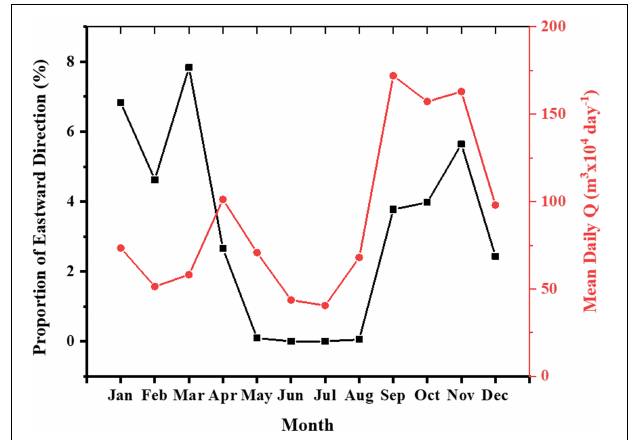
FIGURE 2 | Comparison of longshore currents direction on the north coast as measured by the San Juan buoy vs. mean RGM streamflow for 2012–2019. Red dots and black squares represent the mean daily Q and mean proportion of eastward longshore current direction for each month.